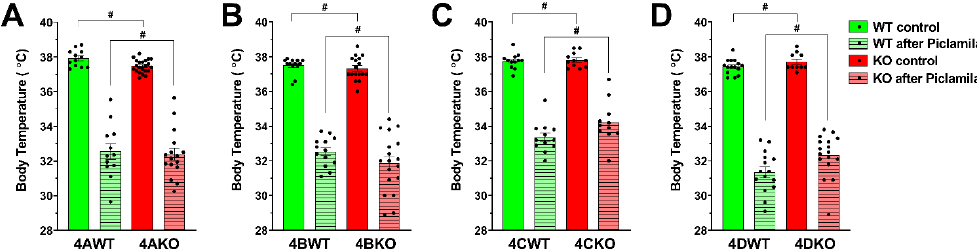
Figure 4. PDE4 inhibitor-induced hypothermia results from the concurrent inactivation of multiple (at least two) PDE4 subtypes . The core body temperature of PDE4 knockout (KO, red bars) mice and their respective wildtype (WT, green bars) littermates was measured just prior to (control, solid colors) and again 30 min after i.p. injection of the PAN-PDE4 inhibitor Piclamilast/RP73401 (after Piclamilast; striated bars; 5 mg/kg). Injection of Piclamilast produced a statistically significant drop in body temperature in all genotypes ( p < 0.01 for 4CKO; p < 0.001 for all others). Conversely, the body temperature of mice deficient in ( A ) PDE4A (4AKO), ( B ) PDE4B (4BKO), ( C ) PDE4C (4CKO) or ( D ) PDE4D (4DKO) was not different from that of their respective wildtype (WT) littermates either prior to or after injection of the PDE4 inhibitor Piclamilast. Data represent the mean ± SEM. Statistical significance was determined using the Mann–Whitney test with 95% confidence interval and is indicated as # ( p > 0.05).